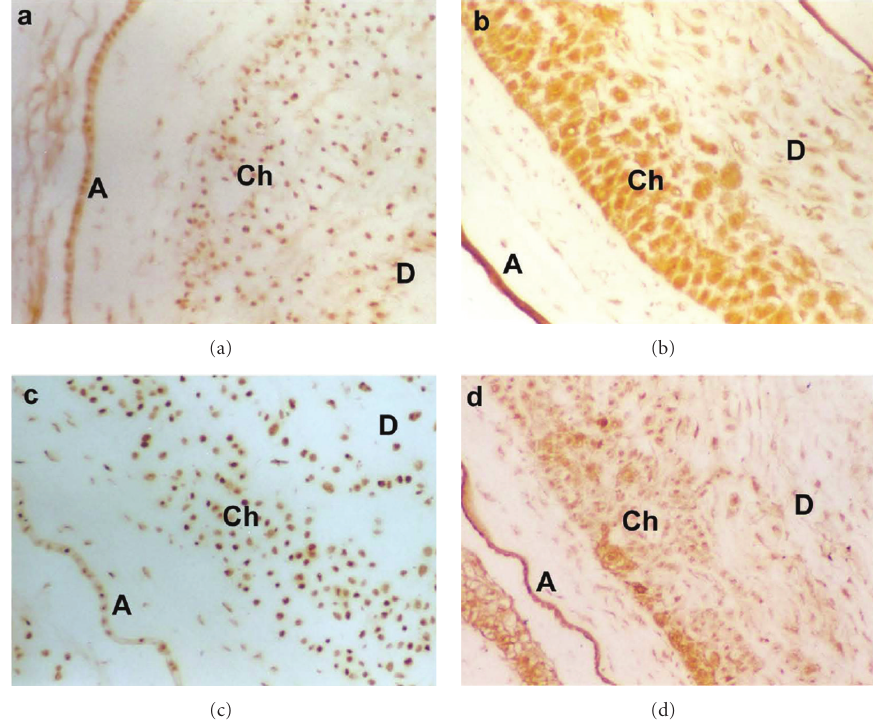
Figure 6: Immunohistochemistry of unseparated fetal membranes stained with antisera specific to SRC-1 (a), SRC-2 (b), p300 (c), and PCAF (d). No counterstain was applied. All pictures were taken at 200 × magnification. A: amnion epithelium. Ch: chorion laeve. D: